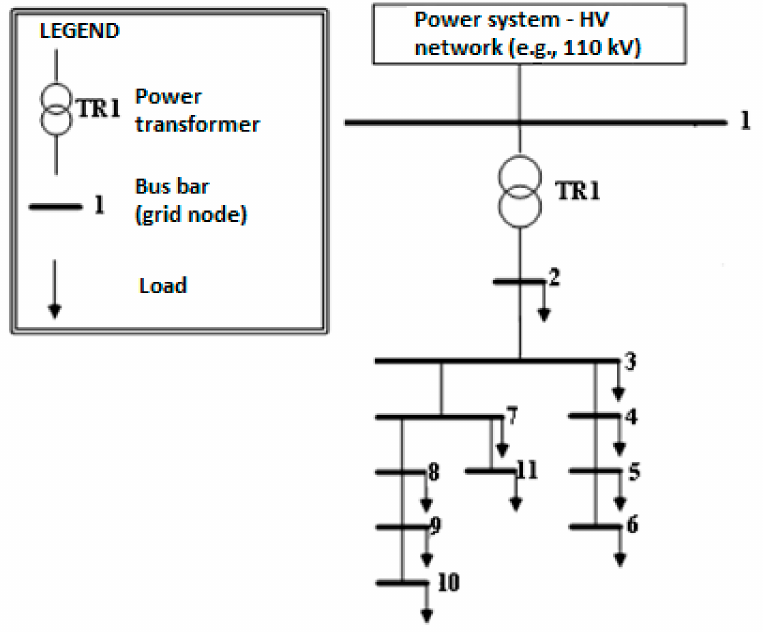
Figure 1. Benchmark model of analyzed medium voltage distribution network.